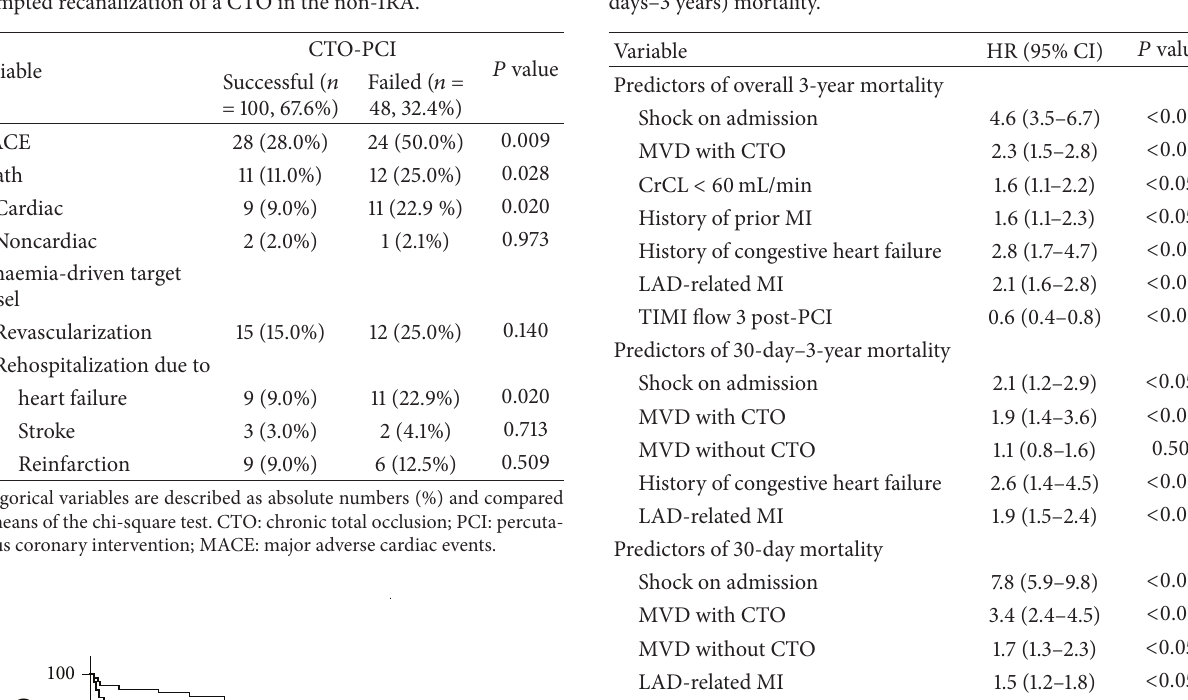
Table 4: Overall 3-year clinical outcomes in patients with CTO of attempted recanalization of a CTO in the non-IRA.